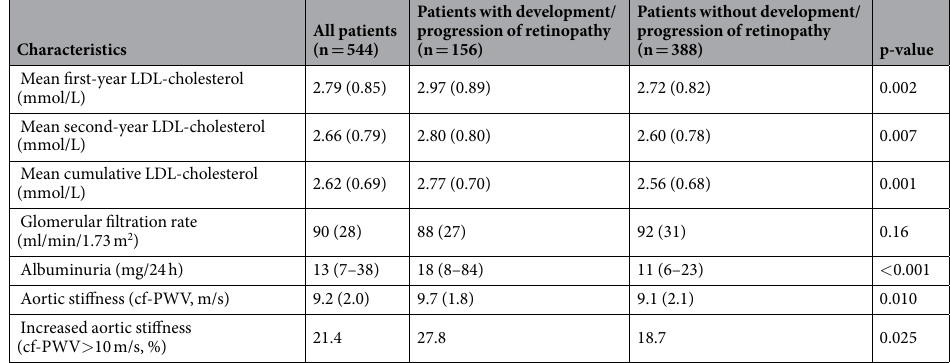
Table 1. Characteristics of diabetic patients divided according to development or progression of retinopathy during follow-up. Values are proportions, and means (standard deviations) or medians (interquartile range). Abbreviations: BMI, body mass index; ACE, angiotensin-converting enzyme; AR, angiotensin II receptor; SBP, systolic blood pressure; DBP, diastolic blood pressure; HbA 1c , glycated hemoglobin; HDL, high-density lipoprotein; LDL, low-density lipoprotein; cf-PWV, carotid-femoral pulse wave